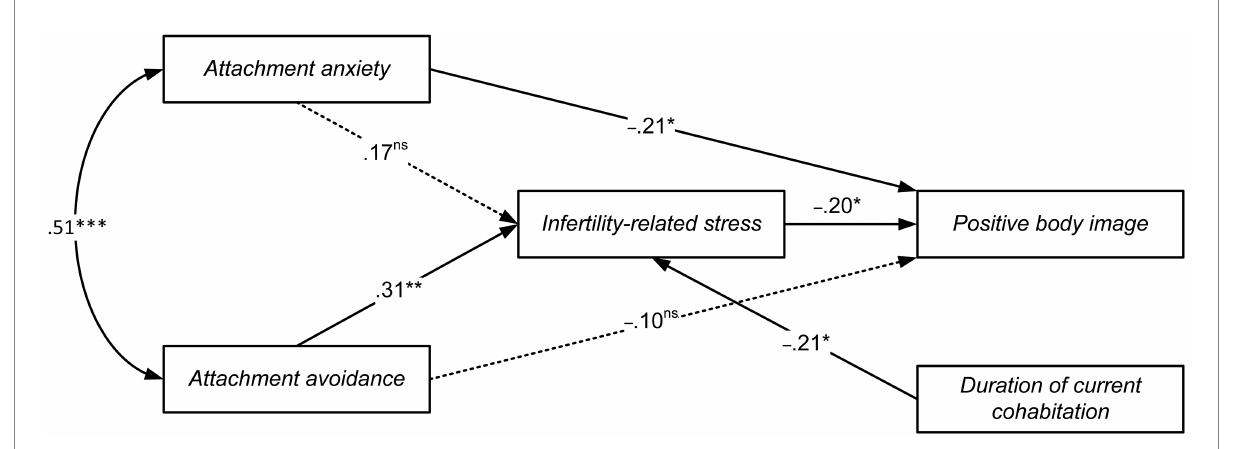
FIGURE 2 Path analysis of the relationship between attachment anxiety, attachment avoidance, and positive body image, as mediated by infertility-related stress. Path coefficients are standardized; Not significant paths are represented with dotted lines; ns = not significant; * p < 0.05, ** p < 0.01, *** p < 0